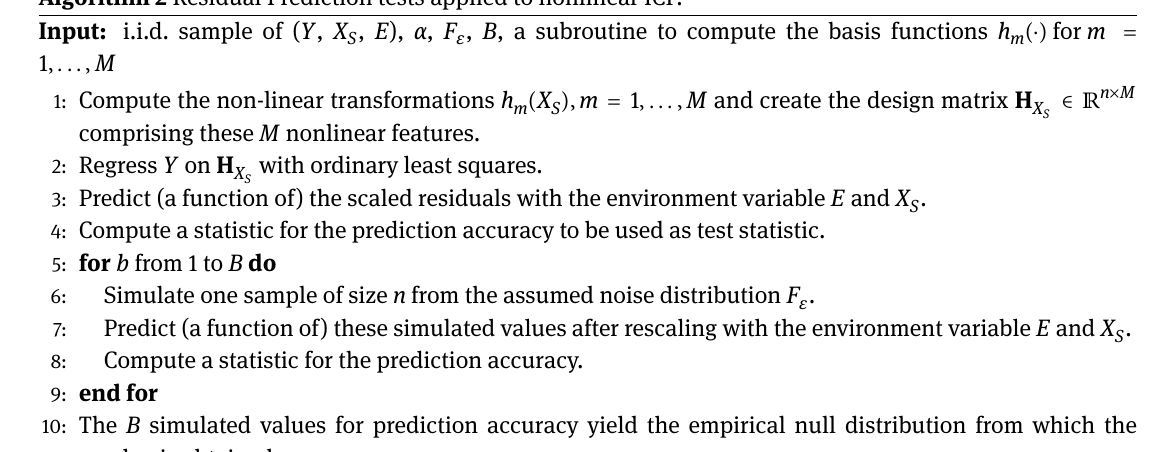
Algorithm 2 Residual Prediction tests applied to nonlinear